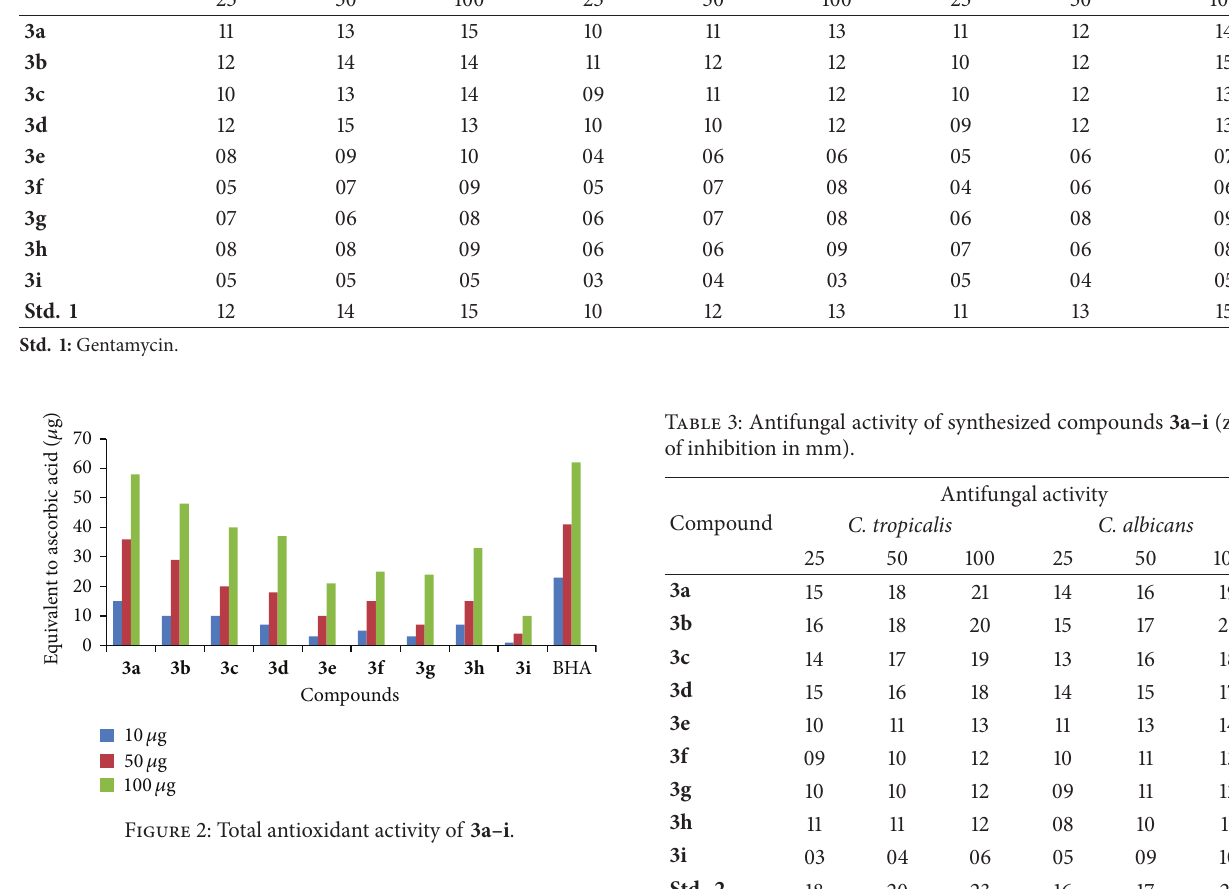
Table 2: Antibacterial activity of synthesized compounds 3a–i (zone of inhibition in mm). Compound